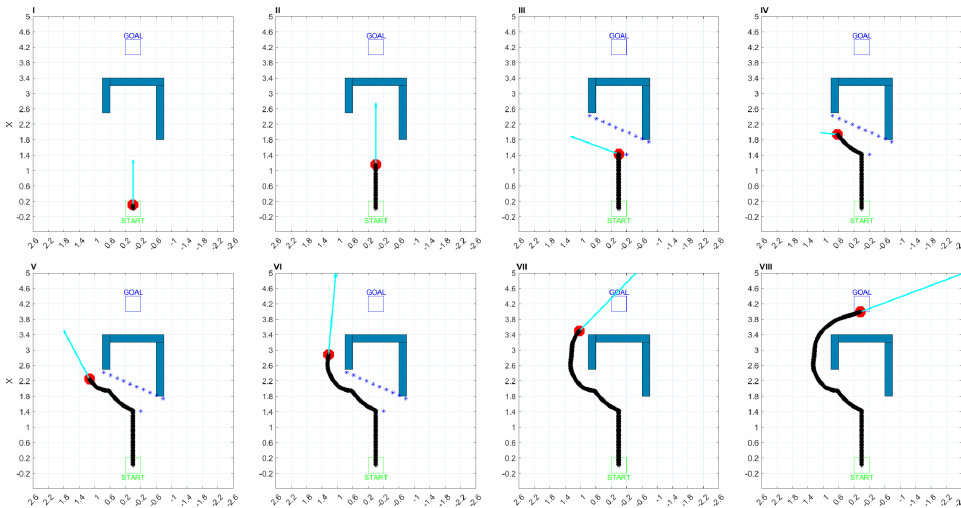
Figure 9. Results of applied AR-APF to solve the Test (I)